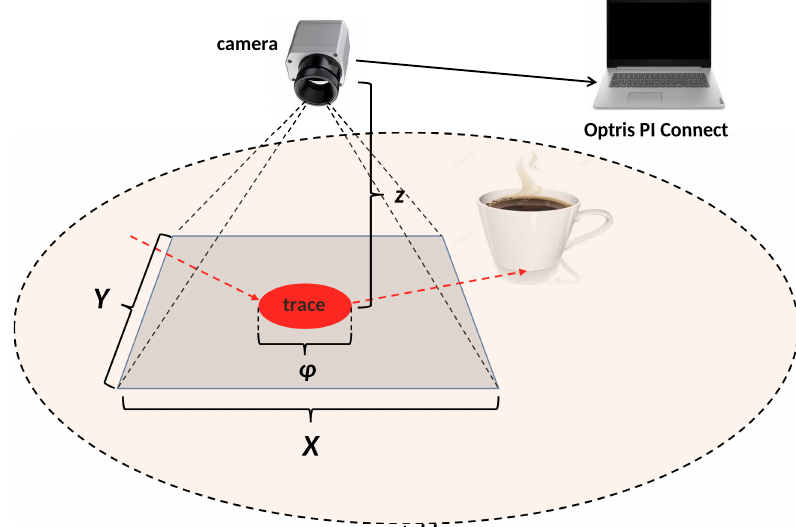
Figure 1. The experimental system.